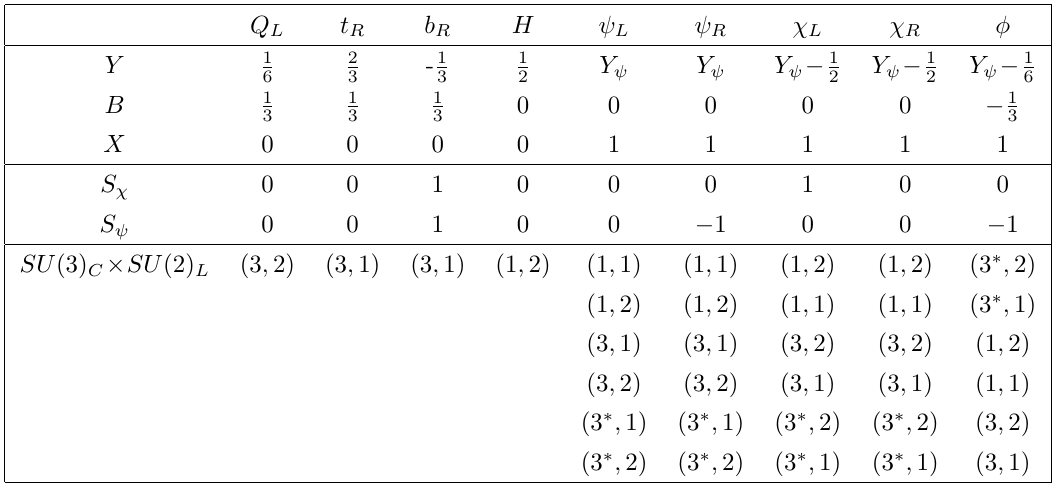
Table 7. Quantum numbers of fields for Class 2 b -quark models. The last six lines list the models containing only singlets and fundamentals under the SM gauge group.